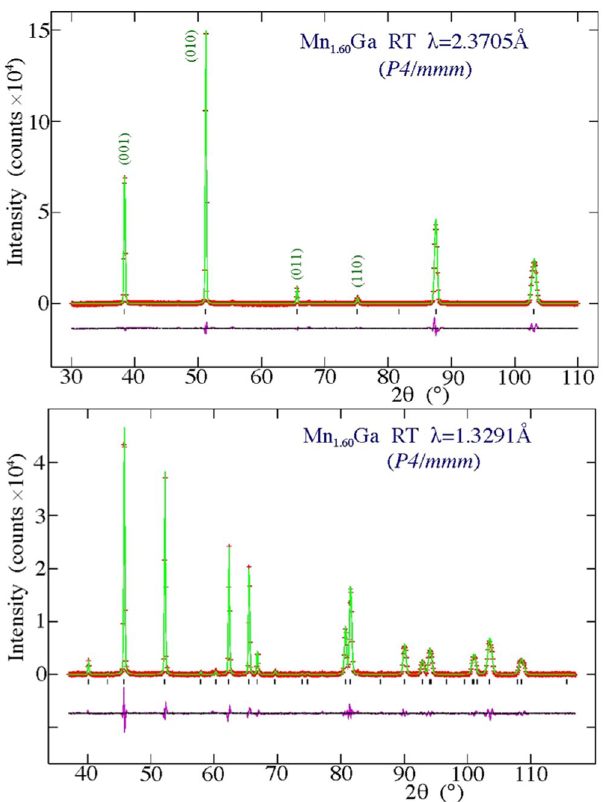
Figure 5. Neutron diffraction patterns for Mn 1.60 Ga taken at ambient temperature ( i.e . below T C ) using (top) 2.37047(8) Å and (bottom) 1.32905(5) Å. The solid line in each case is a fit to the P4/ mmm magnetic and structural model described in the text. Bragg markers and a plot of the residuals are also shown. The two strongest magnetic contributions at (011) and (110) are identified on the 2.37047(8) Å